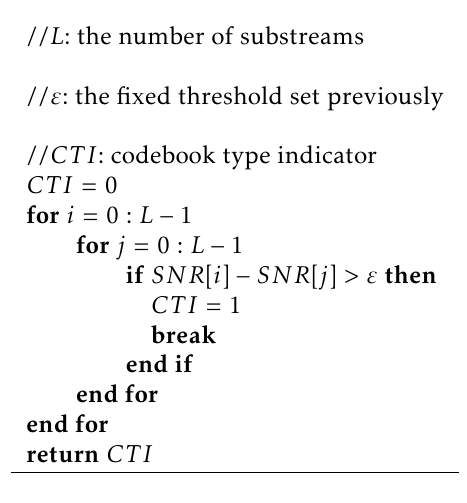
Table 2. Simulated Codebook Type Selection Algorithm Function GetCTI ( SNR [] , L